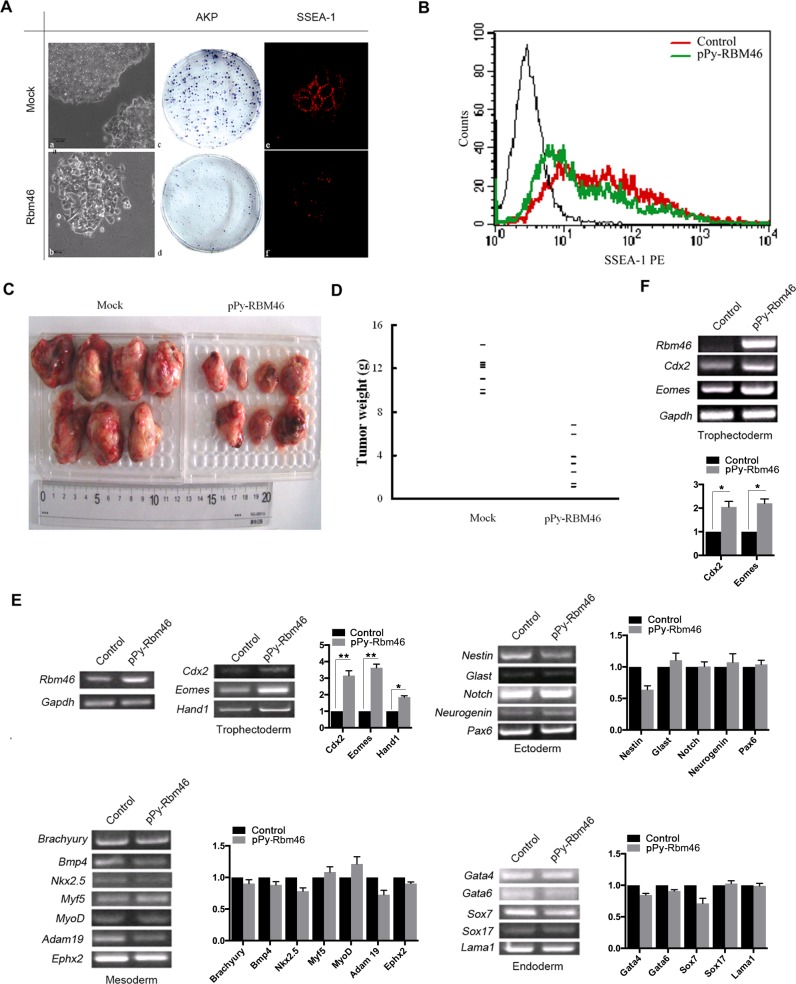
Overexpression of Rbm46 results in differentiation of mESC into trophectoderm.(A) Left panel shows the morphology of the pPE-E14 cells and pPy-Rbm46 cells. Middle panel shows the AKP staining and immunostaining with SSEA-1 antibody of the pPE-E14 cells and pPy-Rbm46 cells. (B) FACs analysis of the SSEA-1 positive cells in pPE-E14 cells and pPy-Rbm46 cells. (C) and (D) Representative images and tumor weight analysis of the teratocarcinoma formed by pPE-E14 cells and pPRbm46 cells. (E) RT-PCR analysis of mRNA level of the marker from different layers in pPE-E14 cells and pPy-Rbm46 cells. The columns show the quantification of the indicated gene relative to Gapdh. The average value in the control group is normalized as 1. Experiment was performed in triplicate. Error bars showed the standard deviation. *, p<0.05; **, p<0.01, t-test. (F) RT-PCR analysis of the trophectoderm markers expressed in the teratocarcinoma formed by pPy-Rbm46 cells. The columns show the quantification of the indicated gene relative to Gapdh. The average value in the control group is normalized as 1. Experiment was performed in triplicate. Error bars showed the standard deviation. *, p<0.05, t-test.